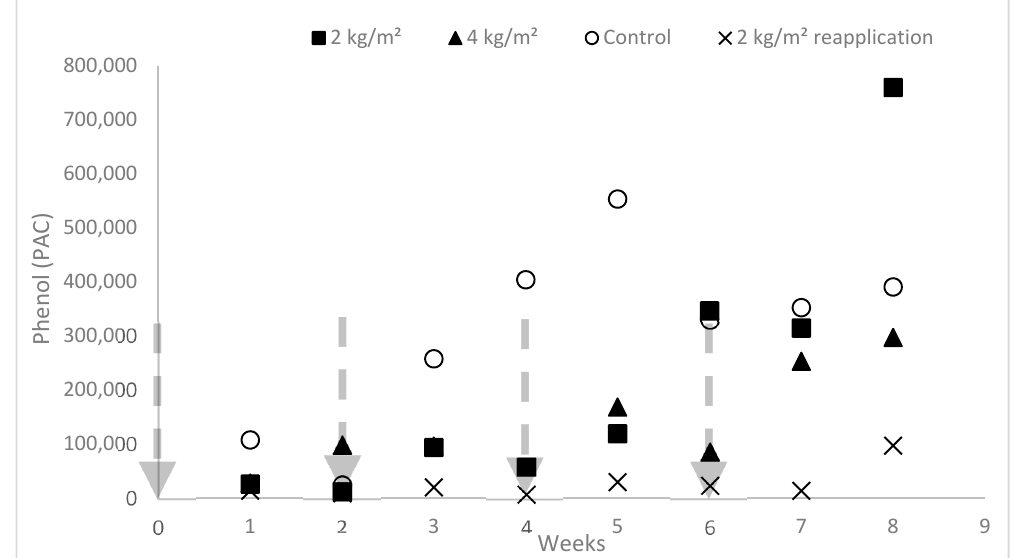
Figure 4. Mitigation of phenol emissions from swine manure treated with biochar—effects of one-time dose (2 and 4 kg/m 2 ) and 2 kg/m 2 bi-weekly reapplication. Vertical arrows represent the application or reapplication of biochar and manure to storage simulators. Each data point represents the mean of ( n = 3) measurements. Detailed statistical analysis is provided in Table S4. A surrogate abundance of indole is represented by (PAC), i.e., peak area counts for indole in the headspace above manure measured by SPME and analyzed by GC-MS. PACs are arbitrary units of M.S. detector